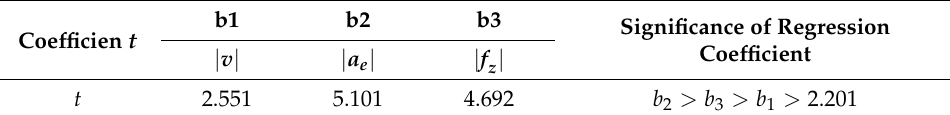
Table 11. Significance test of regression coefficient.